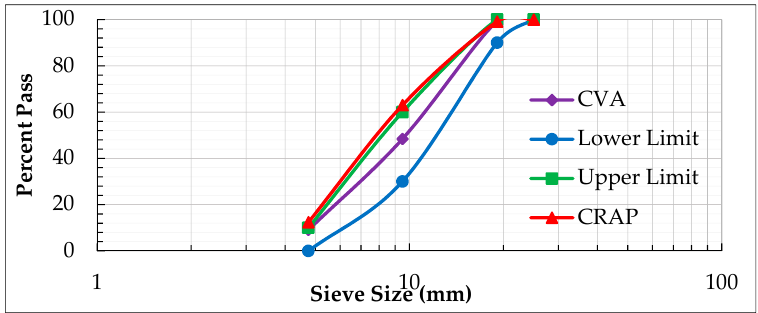
Figure 2. Coarse aggregate particle size distribution as per BS 882 specifications.